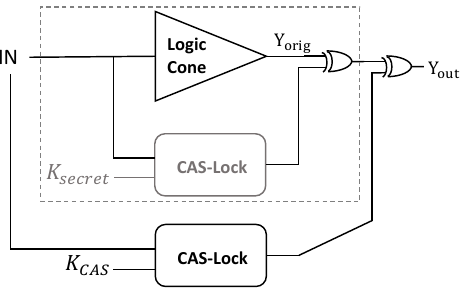
Figure 12: Mirrored